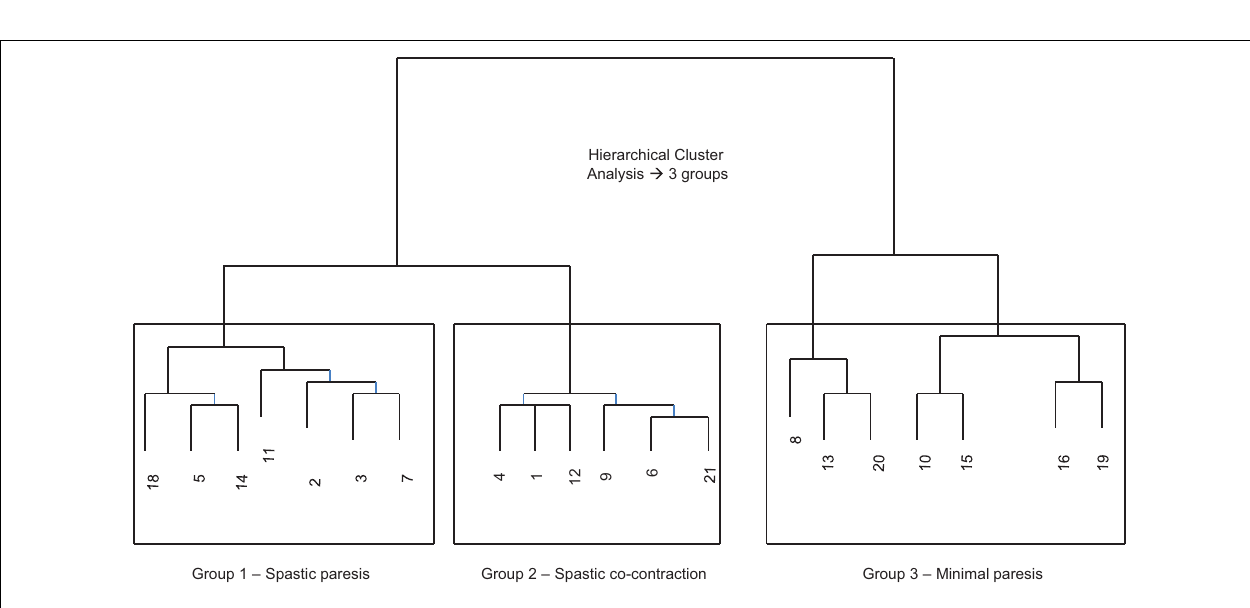
highest in group 1, and similar in groups 2 and 3 ( p =